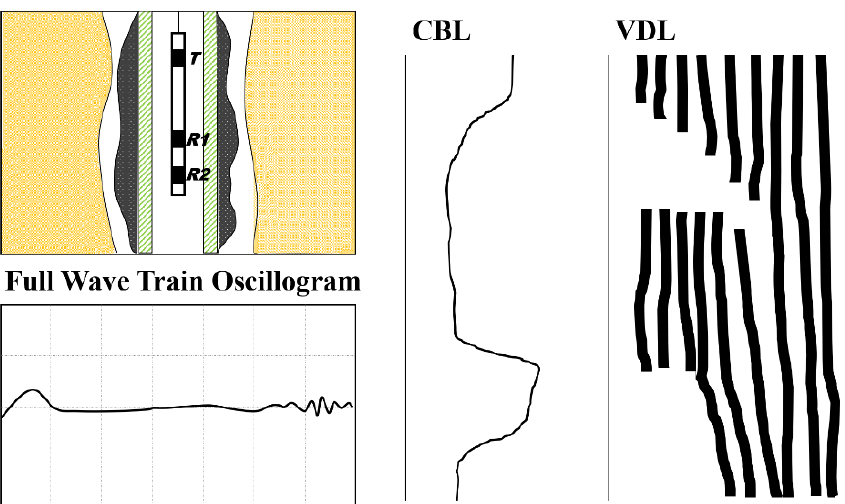
Figure 5. Waveform and CBL-VDL of good cementation at the first interface and poor cementation at the second interface.